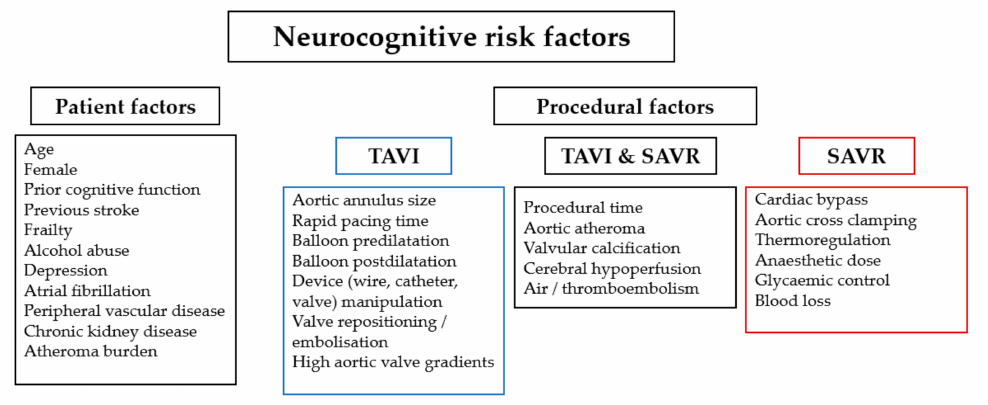
Figure 3. Patient and procedural risk factors for neurocognitive complications.